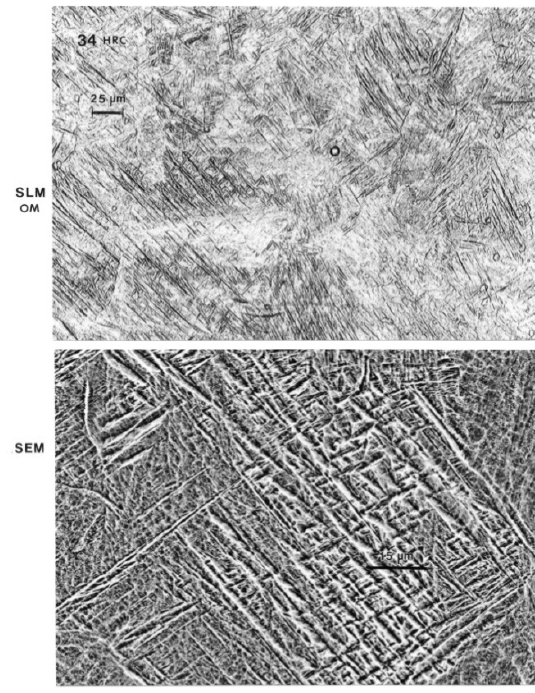
Figure 8. (SLM) Top view shows optical (light) micrograph with primarily α ′ martensite. Bottom views SEM view.